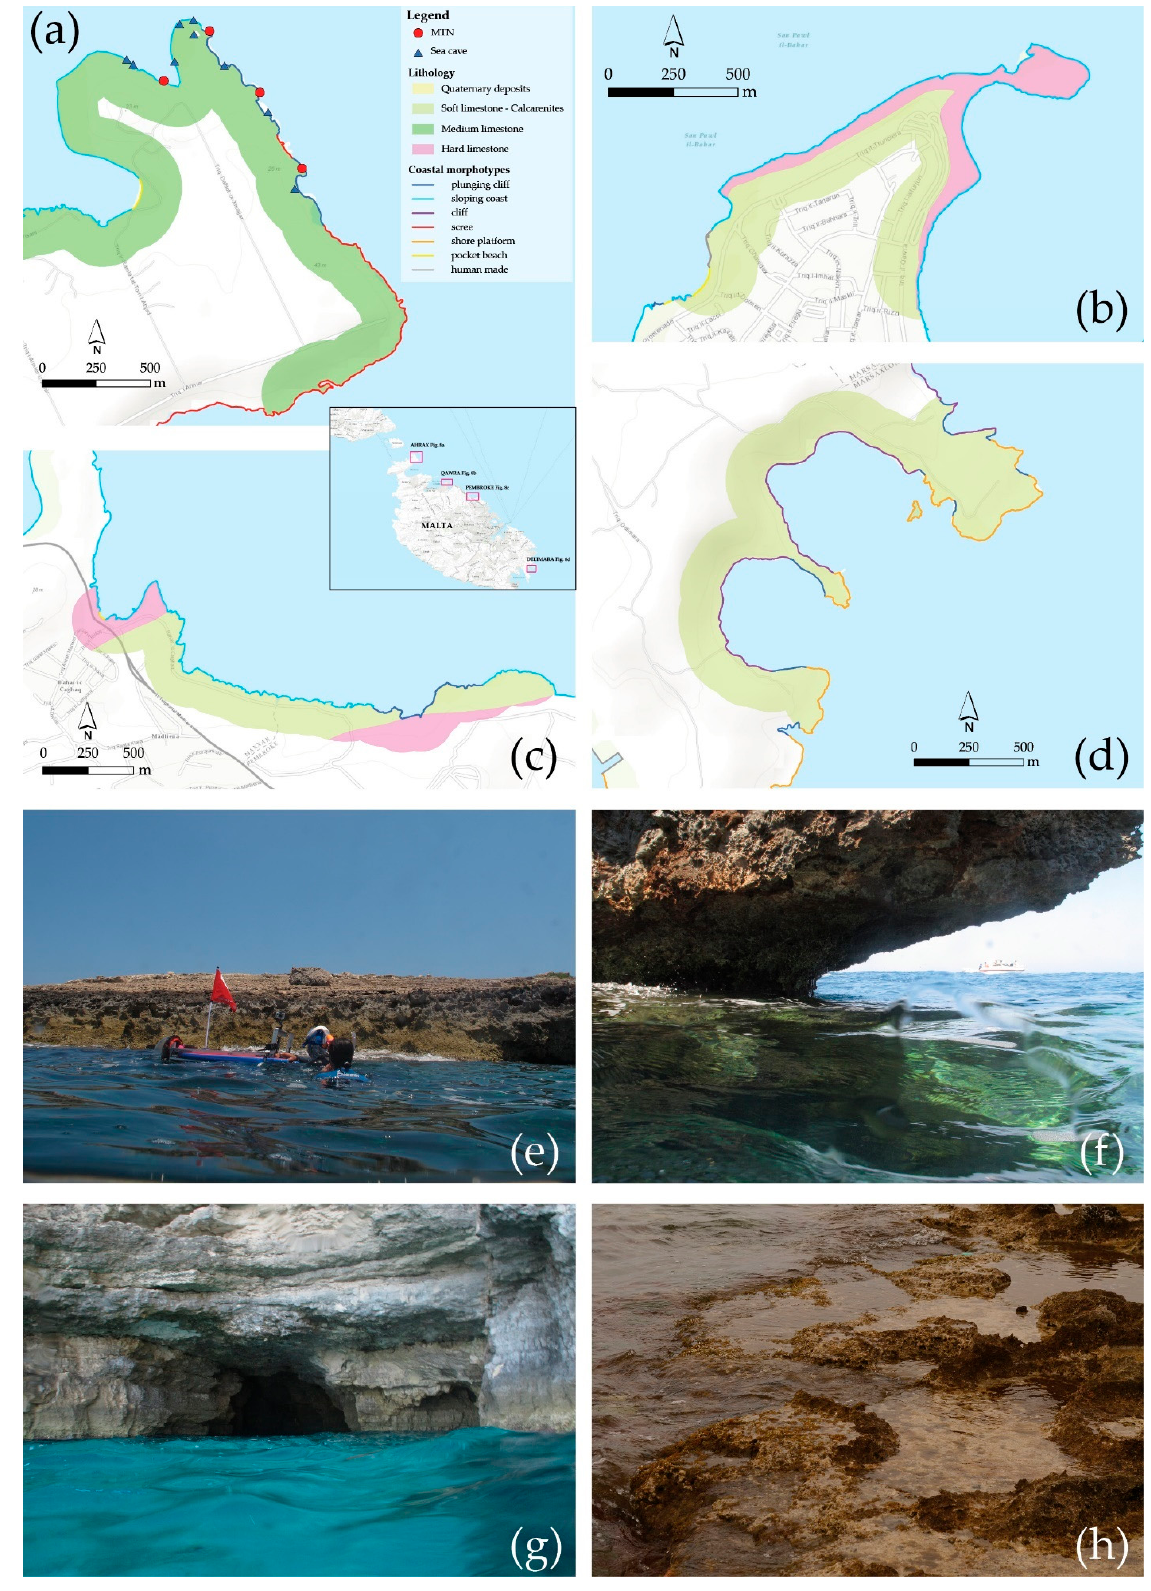
Figure 8. Maps of coastal morphotypes and surveyed geomorphological structures at ( a ) Aħrax ( Mellieħa), ( b ) Qawra, ( c ) Pembroke, and ( d ) Delimara (Xrobb l-Għaġin, Ħofra l-Kbira); ( e ) sloping coast with coastal boulders at Aħrax; ( f ) MTN at Marfa Ridge; ( g ) sea cave at Marfa Ridge; ( h ) vermetid terrace near Pembroke.